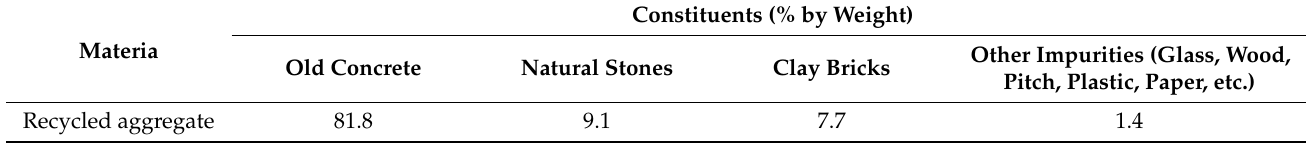
Figure 2. Appearance of natural aggregate and recycled aggregate.